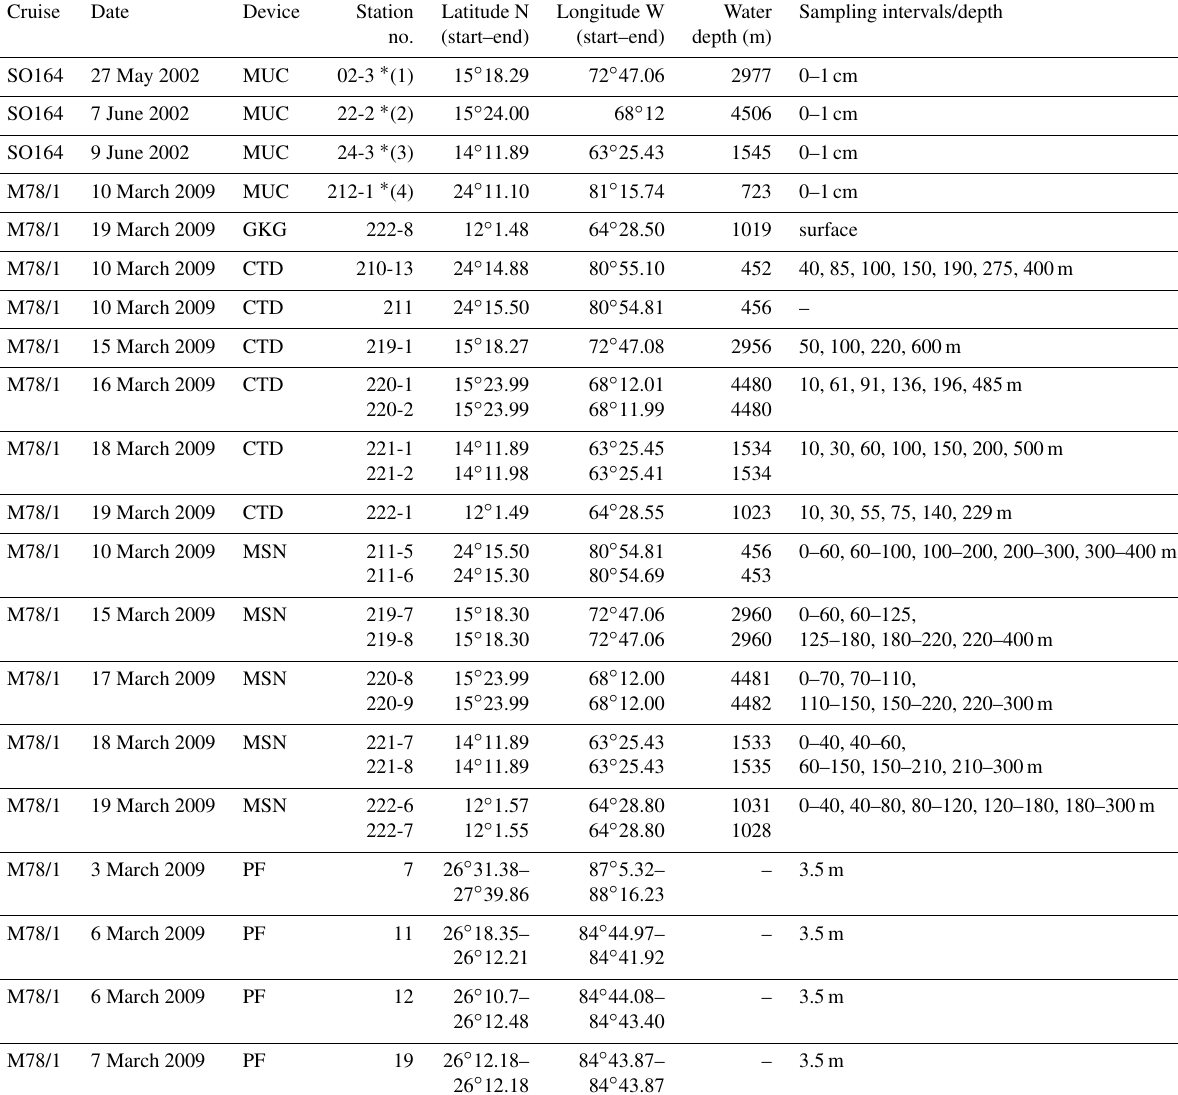
Table 1. Station list of sediment, water and plankton samples obtained during cruises SO164 and M78/1 (Nürnberg et al., 2003; Schönfeld et al., 2011). MUC is the multicorer; GKG is the giant box corer; CTD is the conductivity–temperature–depth profiler; MSN is the Hydrobios Midi multiple opening–closing plankton net; PF is the plankton